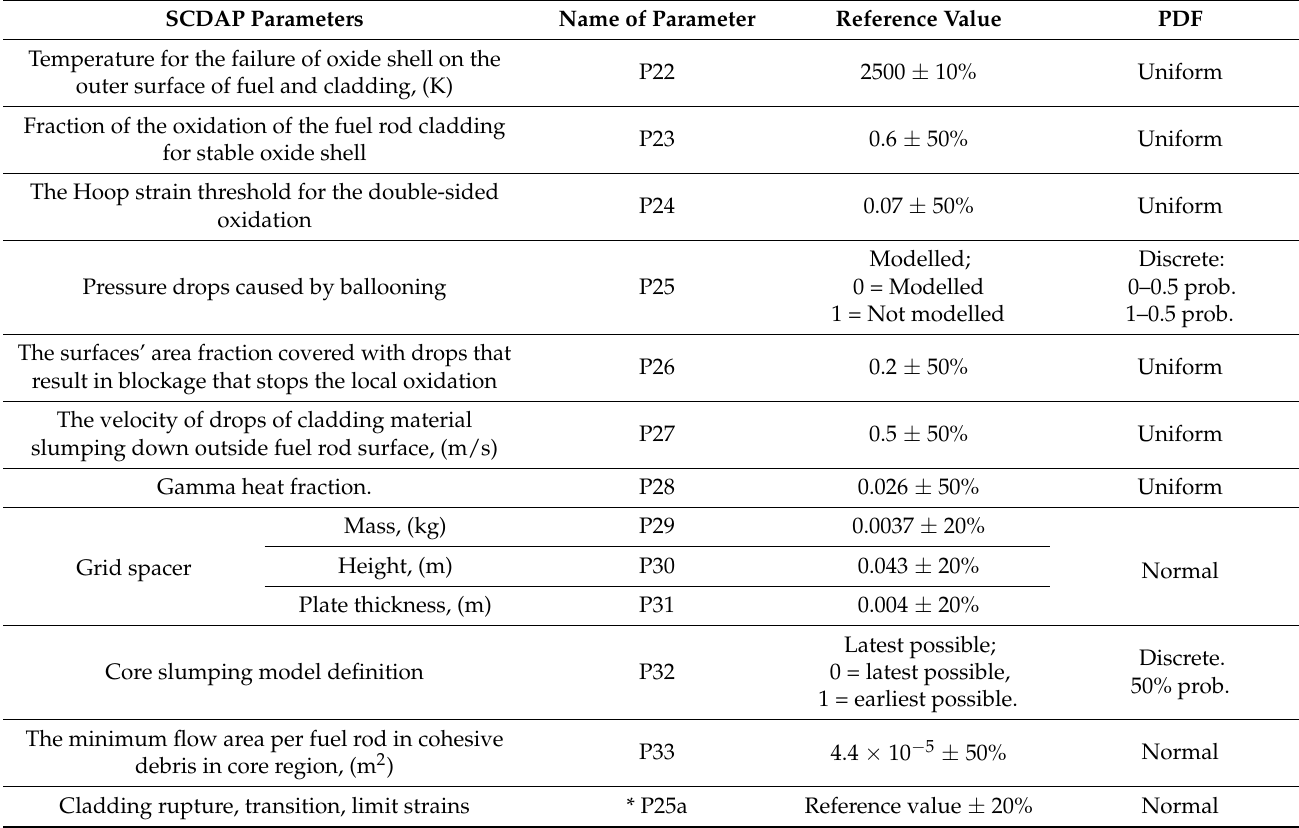
Table 2. Uncertainty characterization of SCDAP